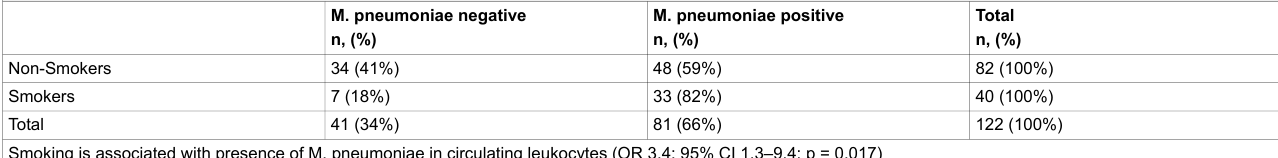
Table 2 Cross tabulation between smoking and presence of M. pneumoniae in circulating leukocytes.